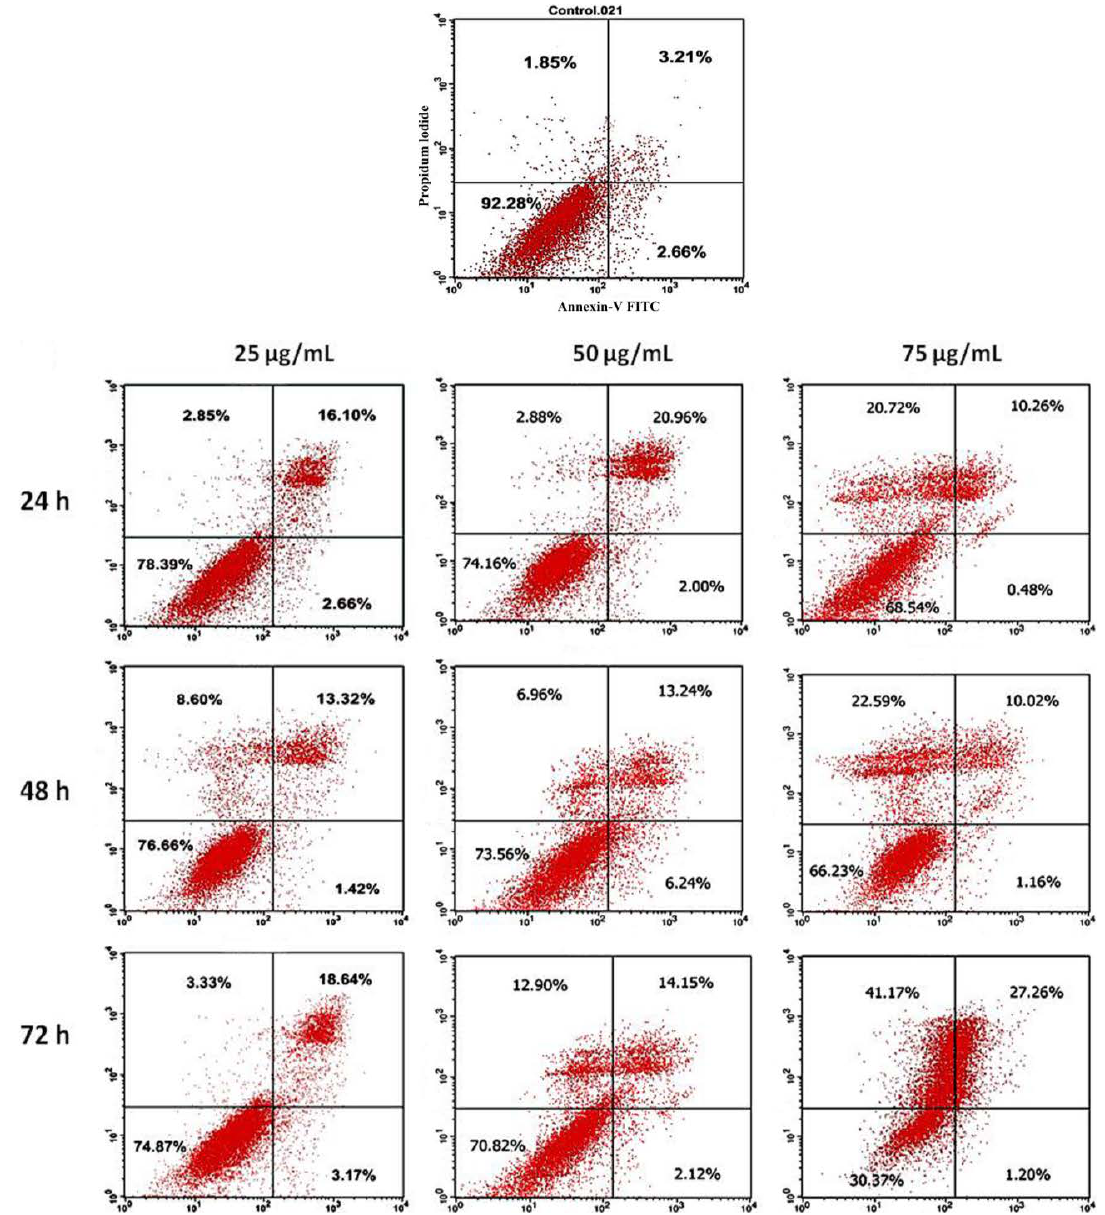
Figure 5. Effects of DMHE on induction of cell death in HT-29 cells. The cells were treated with different concentrations of DMHE (25, 50 and 75 µg/mL) in a time dependent manner (24, 48 and 72 h), labelled with FITC (fluorescein-isothiocyanate) annexin V and PI (propidium